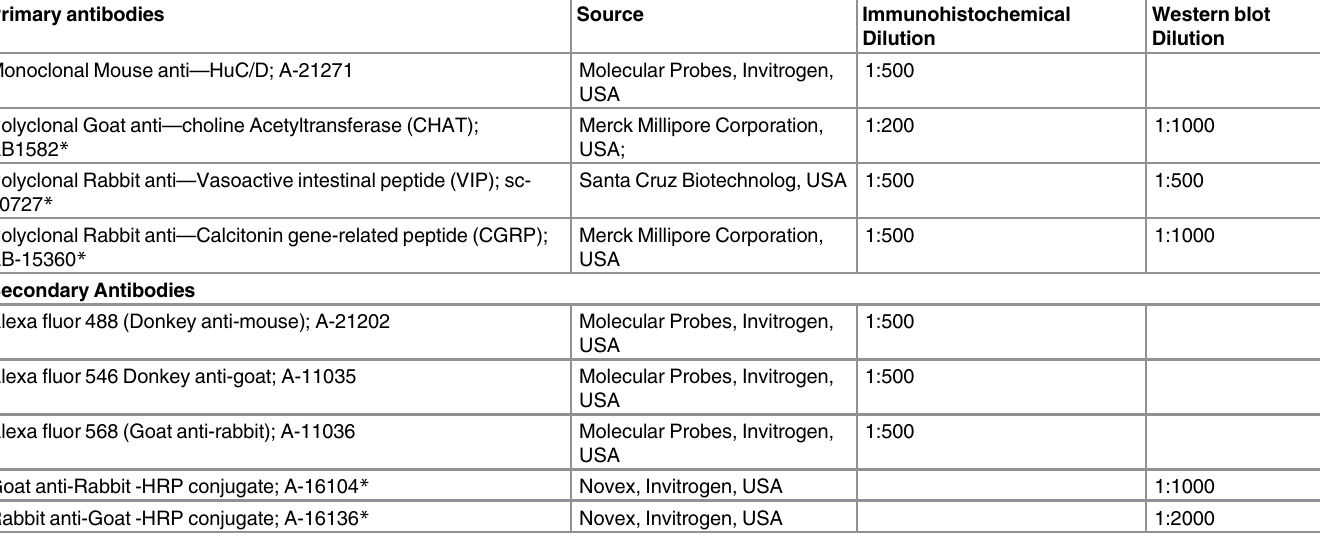
Table 1. Characteristics of the primary and secondary antibodies used in